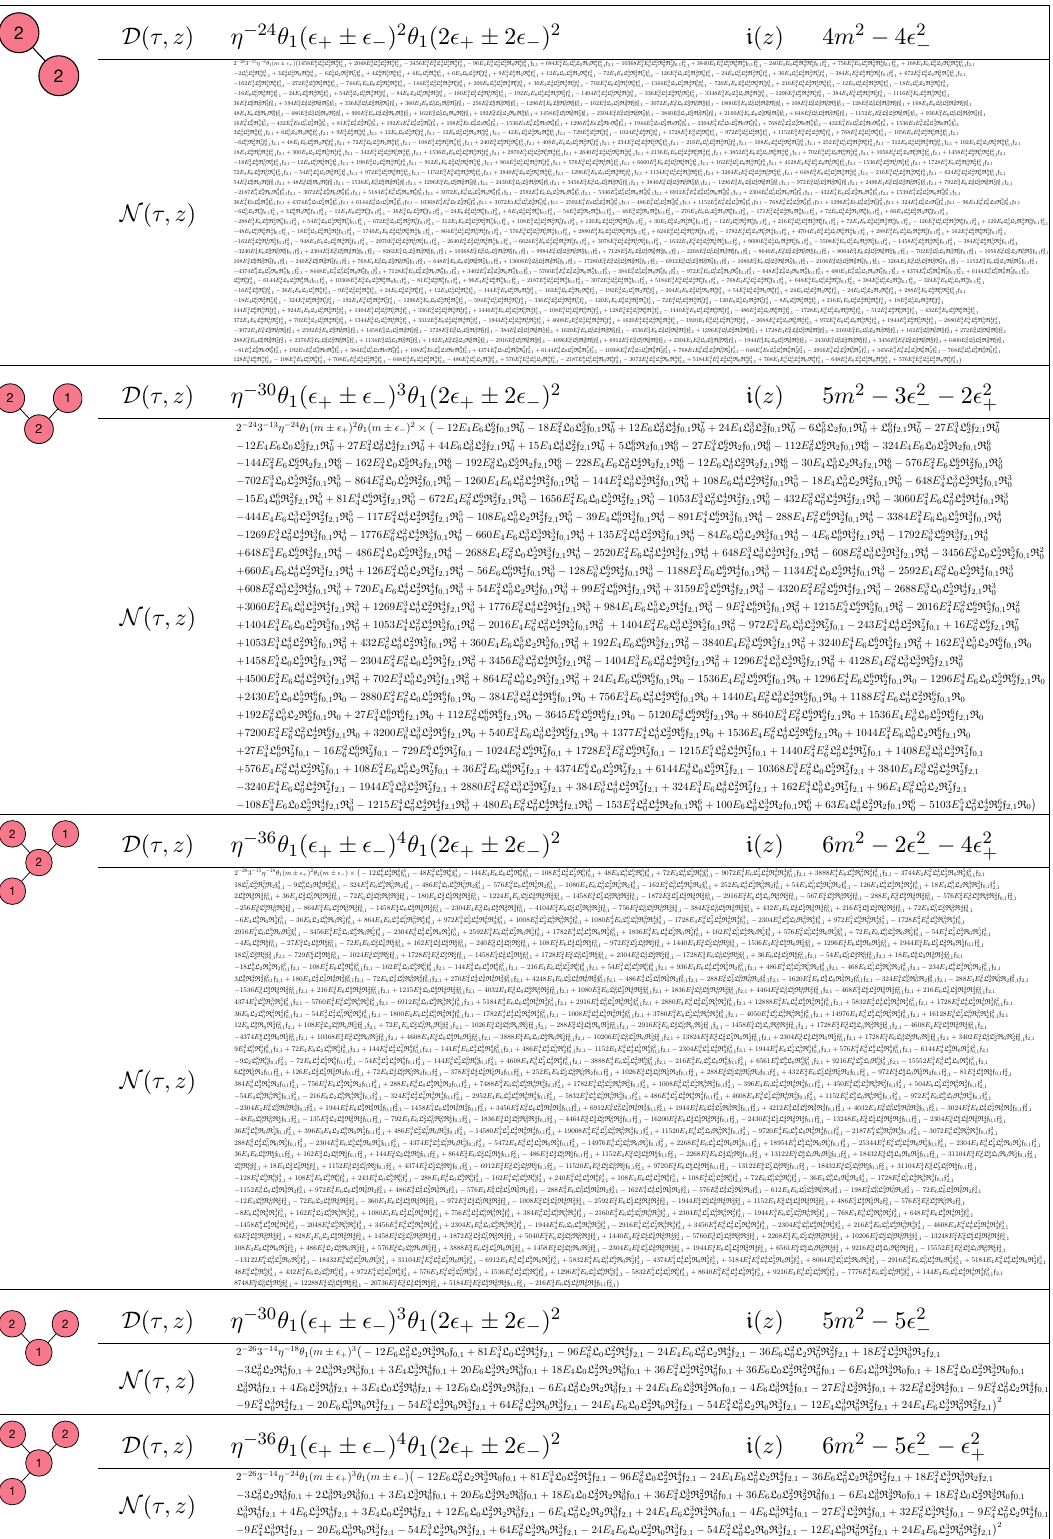
Table 6 . Elliptic genera of (2 ; 0) string chains determined from I 0